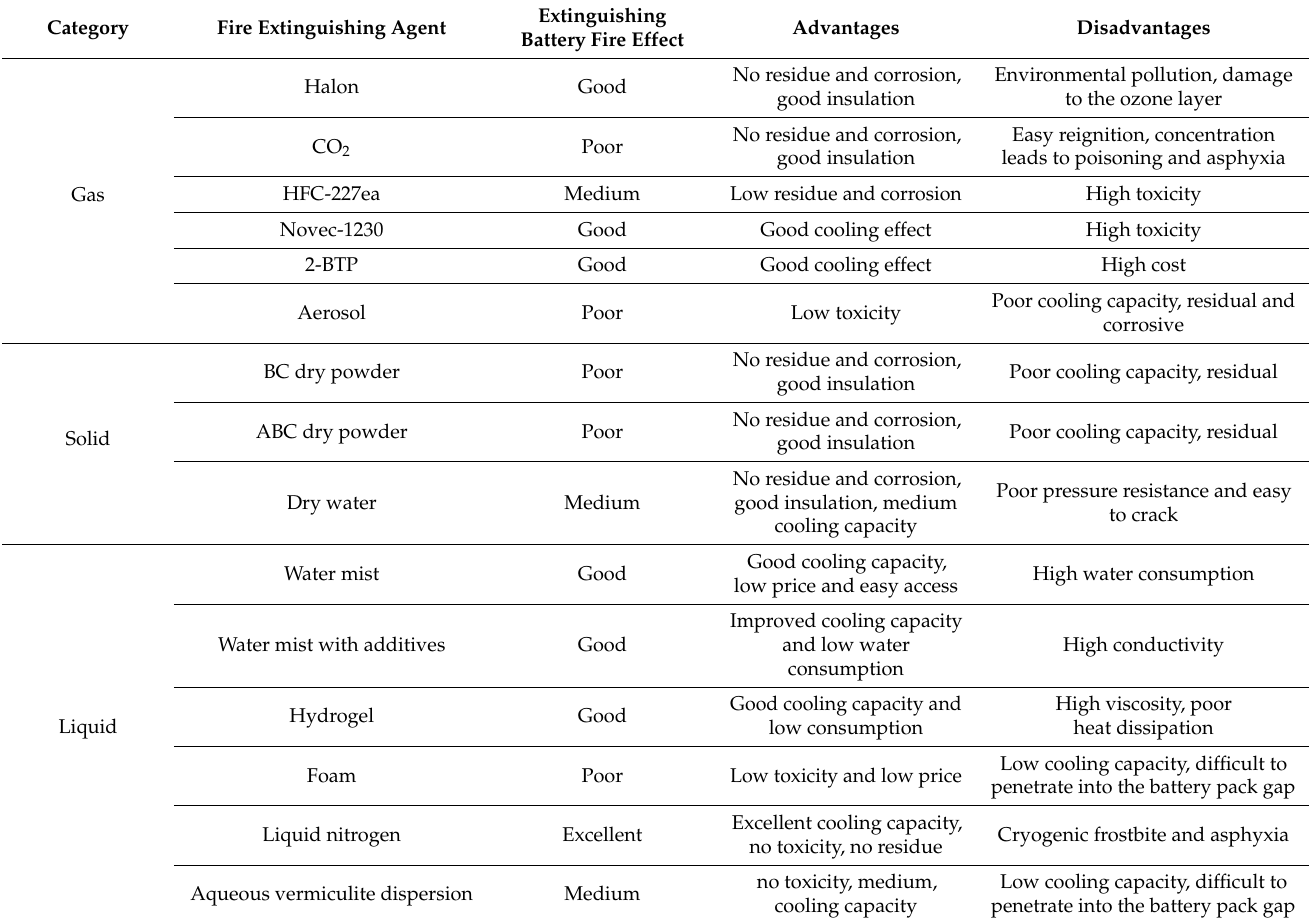
Table 4. Effect of fire extinguishing agent and its advantages and